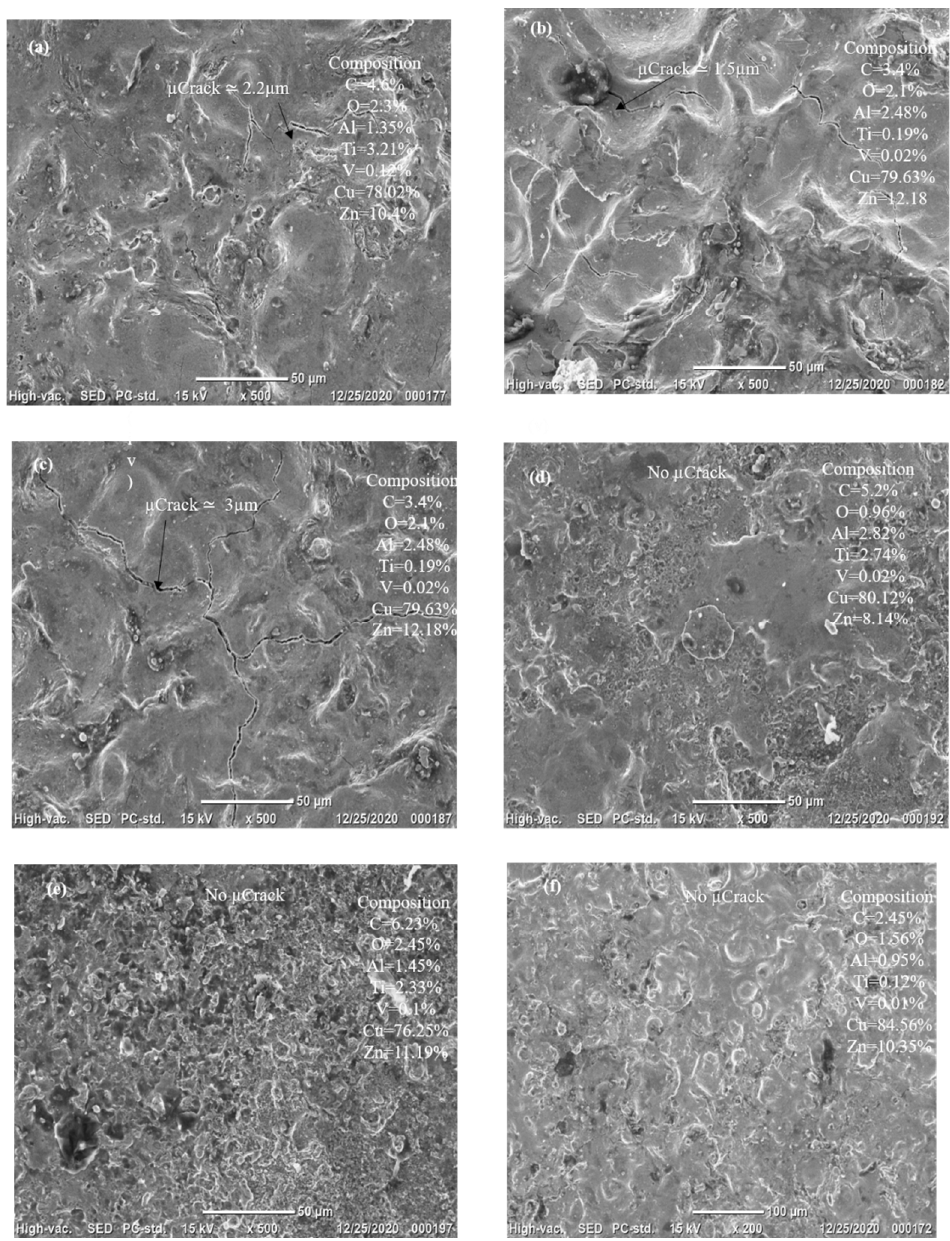
Figure 8. Surface morphology of coating by SEM Images, shown in the order of ( a – f ) respectively.